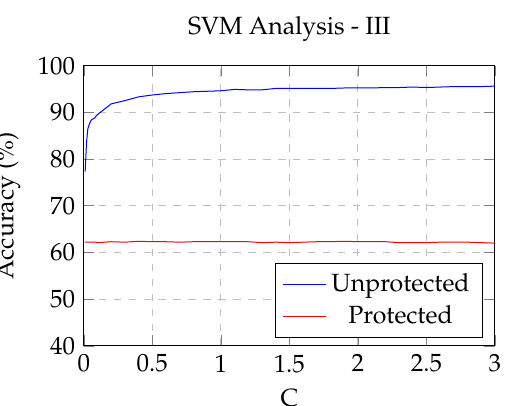
Figure 10. Impact on accuracy of C value for SVM model.